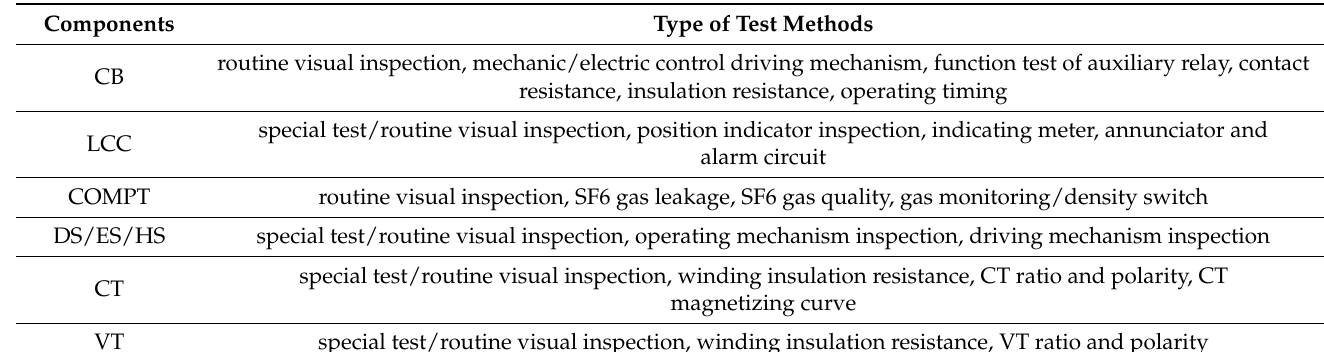
Table 1. Field diagnostic and testing